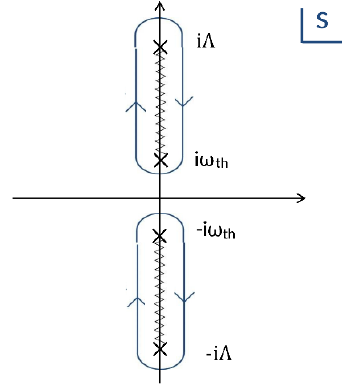
Figure 6 . The contour for the inverse Laplace transform used to compute G (cid:30); 1 ( t ) and G (cid:30); 2 ( t ) in a bath of the relativistic free (cid:12)eld. There exist the cuts but the poles are on other Riemann